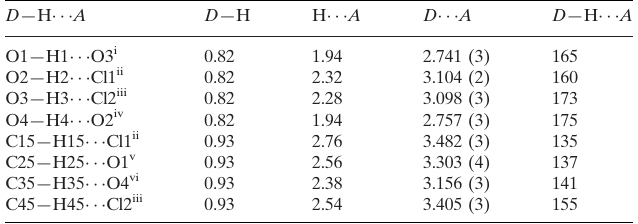
Hydrogen-bond geometry (A˚ , (cid:2)